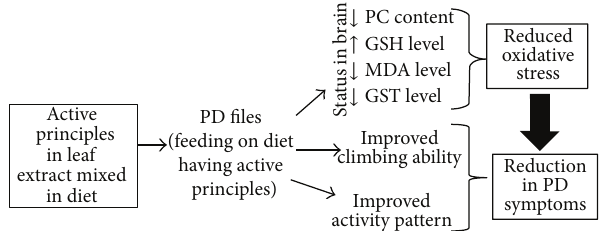
Figure18:Possiblemechanismofprotectionby Centellaasiatica leaf extract in Parkinson’s disease model transgenic